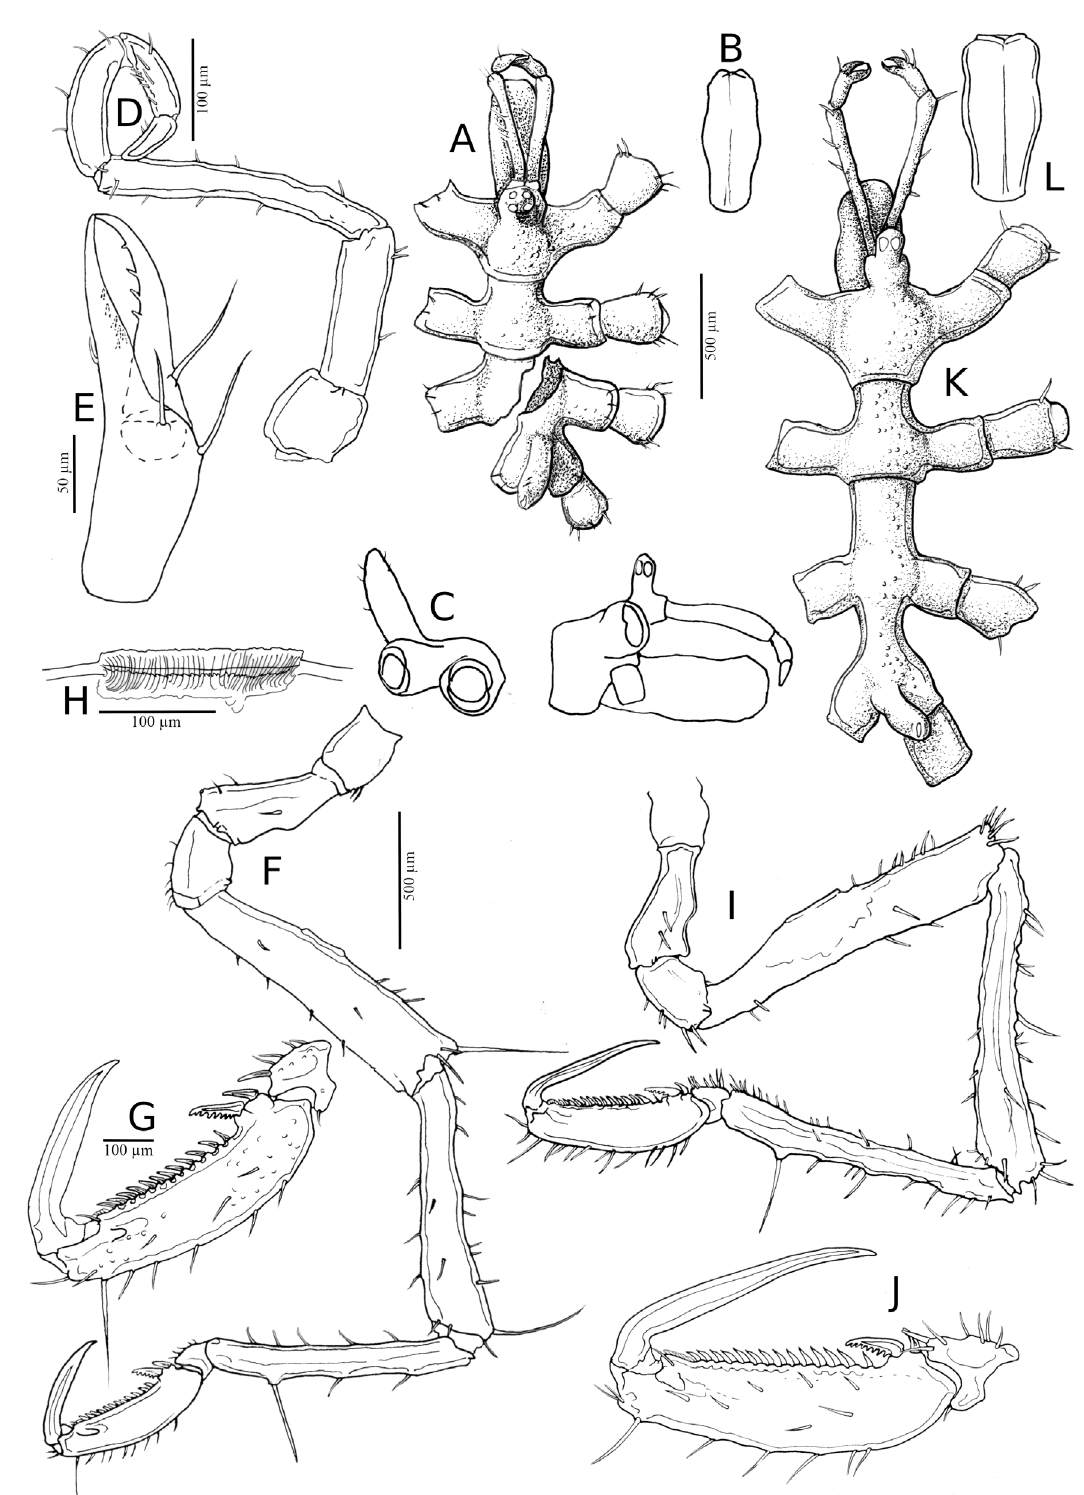
Fig. 22. Comparison of Anoplodactylus madibenthos sp. nov. (A–J) and A. pectinus Hedgpeth, 1948 (K–L). A–J . Holotype, ♂, MNHN-IU-2016-1071 . K–L . MNHN-IU-2016-1254. A . Body, dorsal view. B . Proboscis in ventral view. C . Body lateral view (same scale as A). D . Oviger. E . Chela. F . Third leg. G . Tarsus and propodus of third leg. H . Cement gland opening. I . First leg. J . Tarsus and propodus of first leg. K . Body, dorsal view. L . Proboscis in ventral view (same scale a